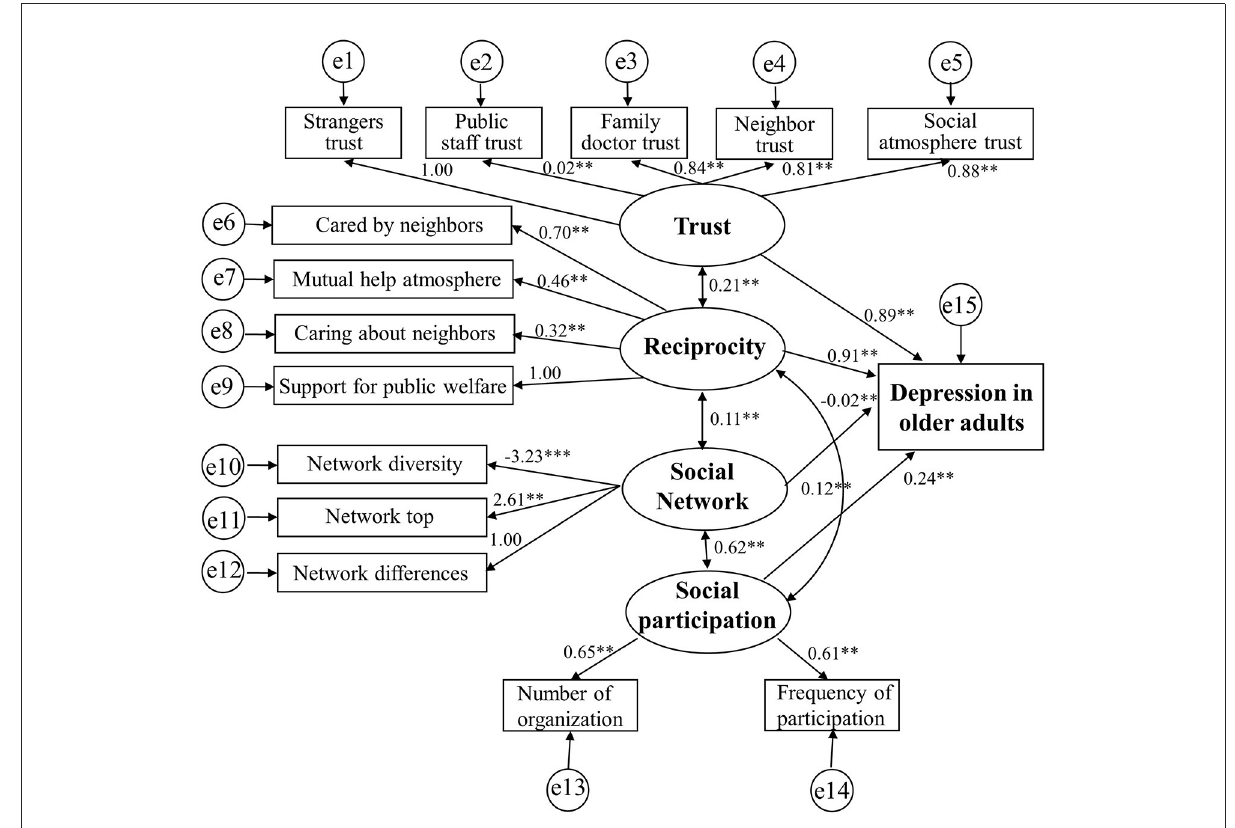
FIGURE3 The relationship between social capital and depression in male